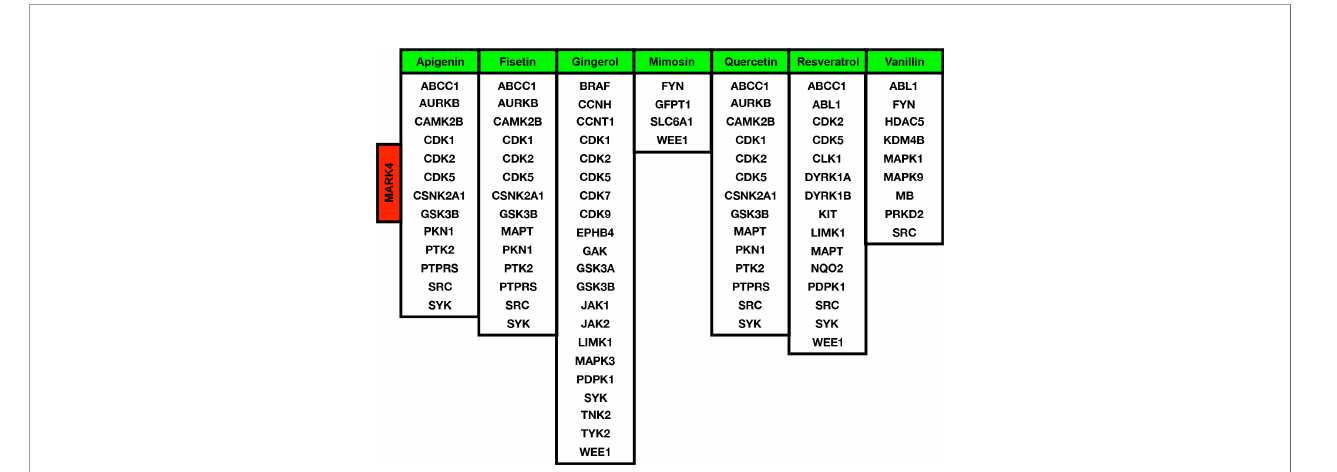
FIGURE 4 | Proteins are common with the selected herbal drug target proteins